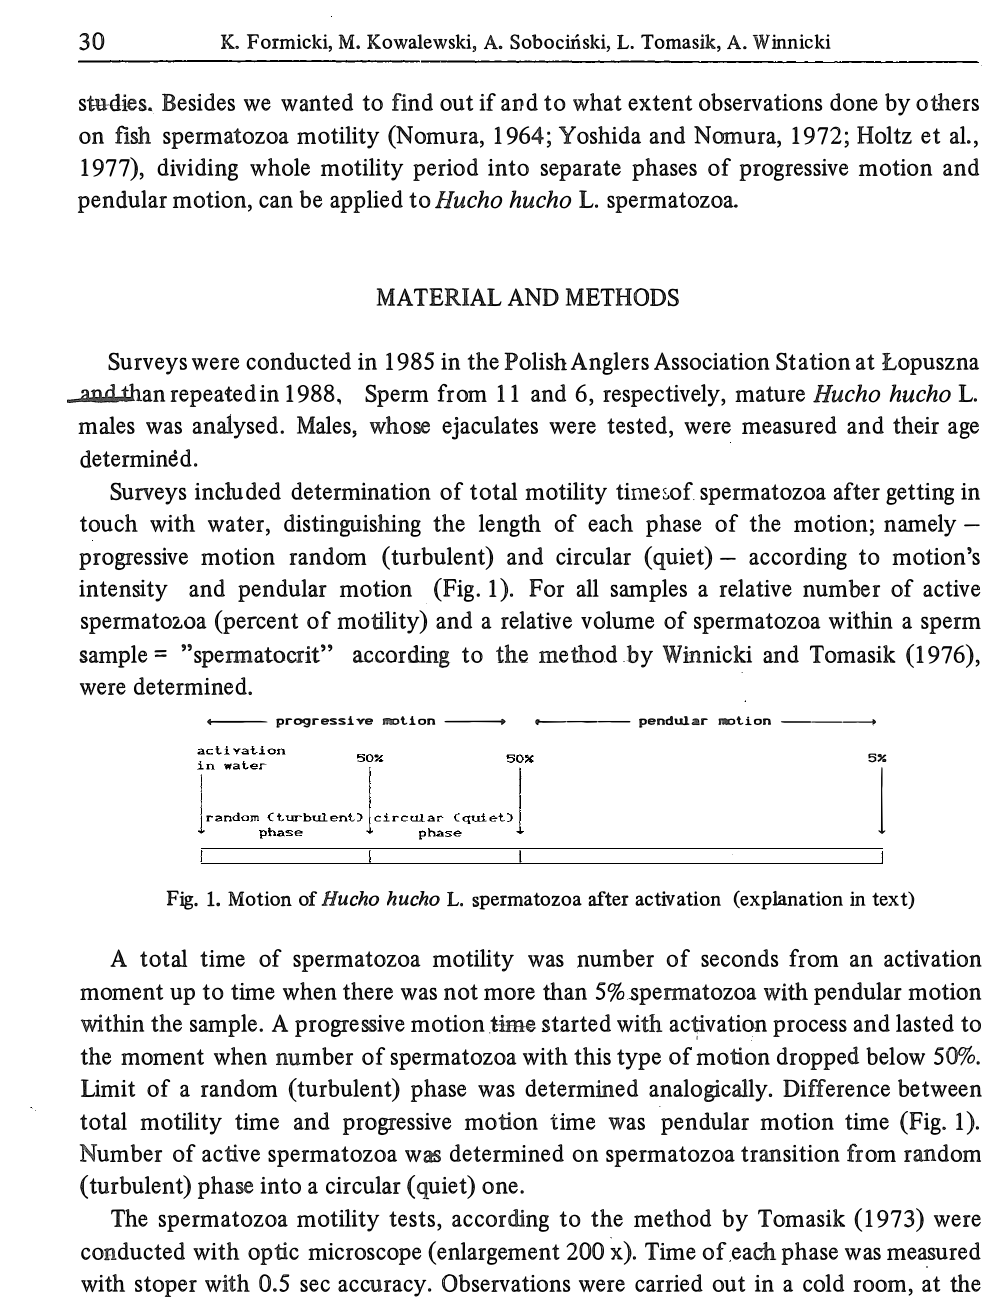
Fig. 1. Motion of Hucho hucho L. spermatozoa after activation (explanation in